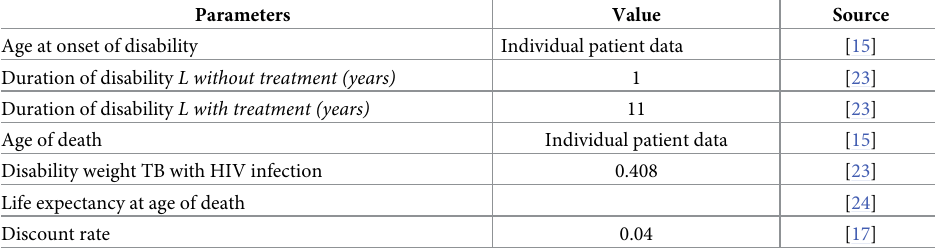
Table 1. Parameters for DALYs